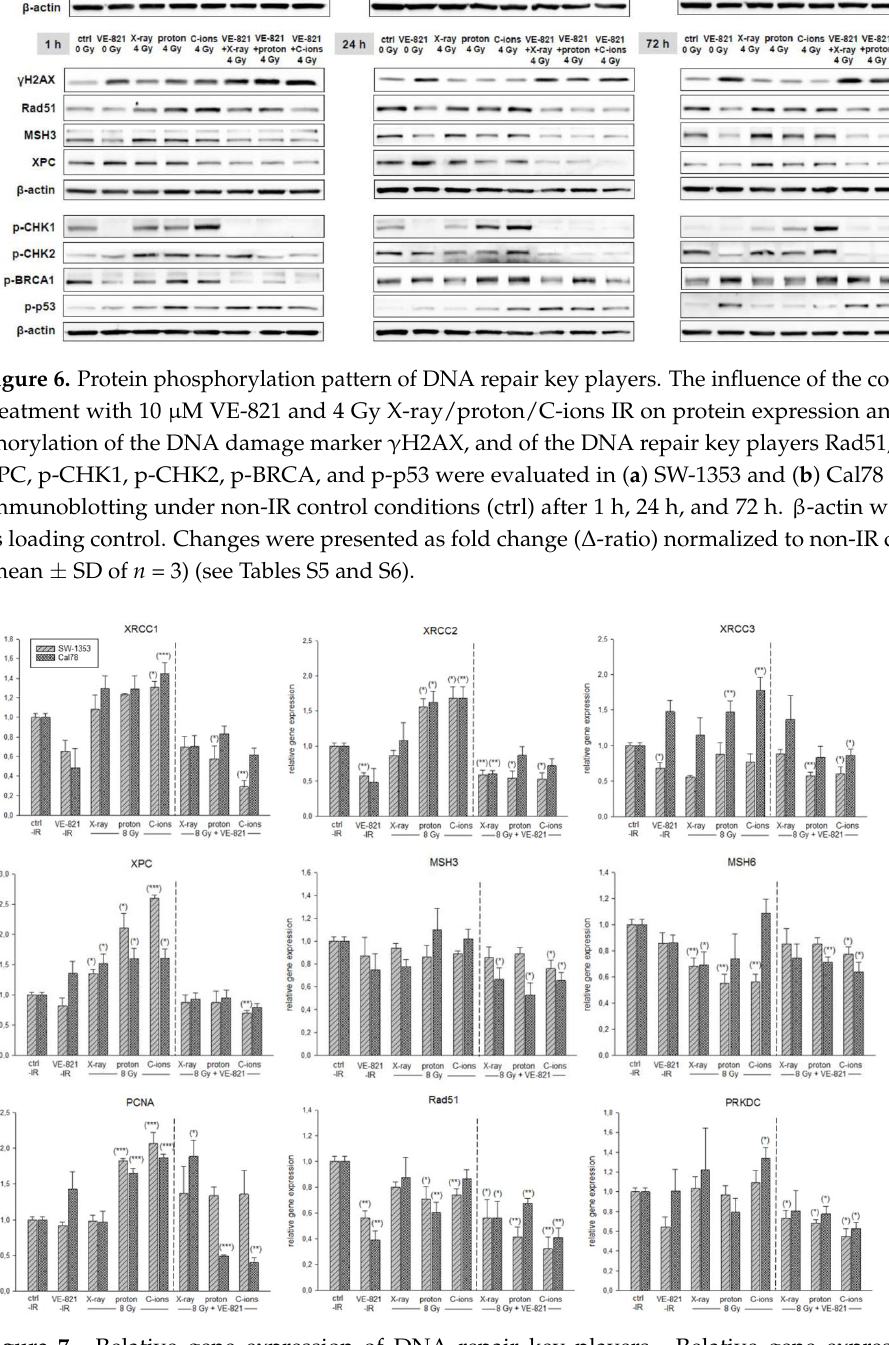
Figure 7. Relative gene expression of DNA repair key players. Relative gene expression of XRCC1/2/3, XPC, MSH3/6, PCNA, Rad51, and PRKDC 24 h after combined treatment with 10 µM VE-821 and 4 Gy X-ray/proton/C-ions IR in SW-1353 (light grey-striped) and Cal78 (dark grey-dotted) chondrosarcoma cells (mean ± SD; n = 6; measured in triplicates). Non-IR cells were used as controls (ratio = 1). Statistical significances are defined as follows: * p < 0.05; ** p < 0.01; *** p < 0.001.